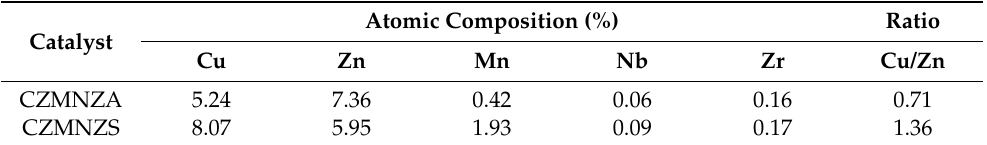
Figure 6. Particle size distribution of CZMNZA and CZMNZS. Table 3. Atomic compositions of